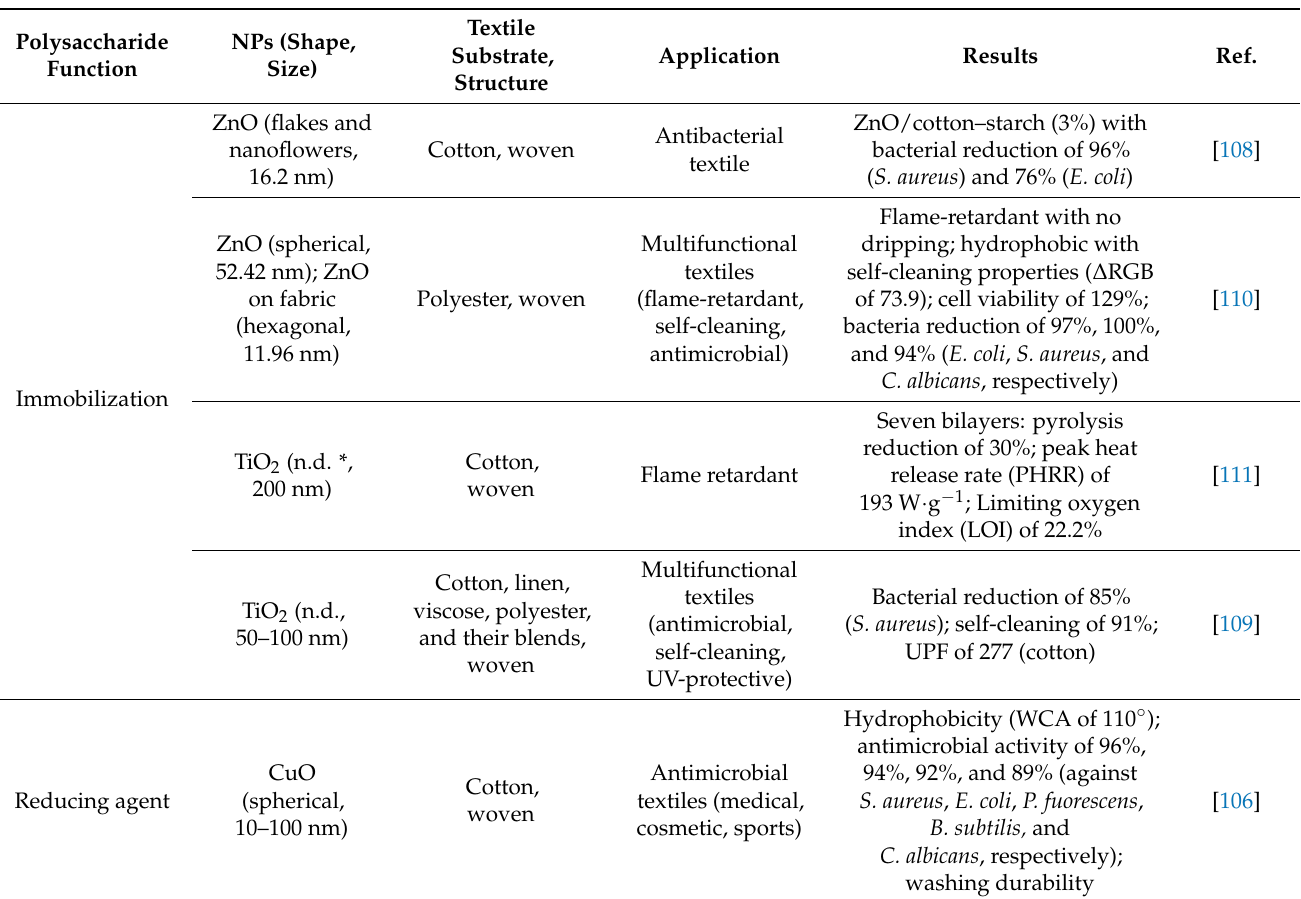
Table 3. Textile materials functionalized with starch and metal nanoparticles. Polysaccharide function towards